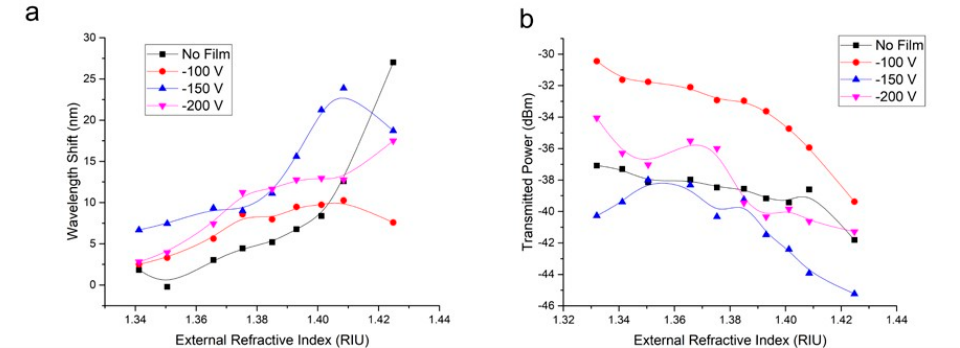
Figure 3. Wavelength shift ( a ) and transmitted power ( b ) for the different self-bias on coated sensors and the comparison of the uncoated